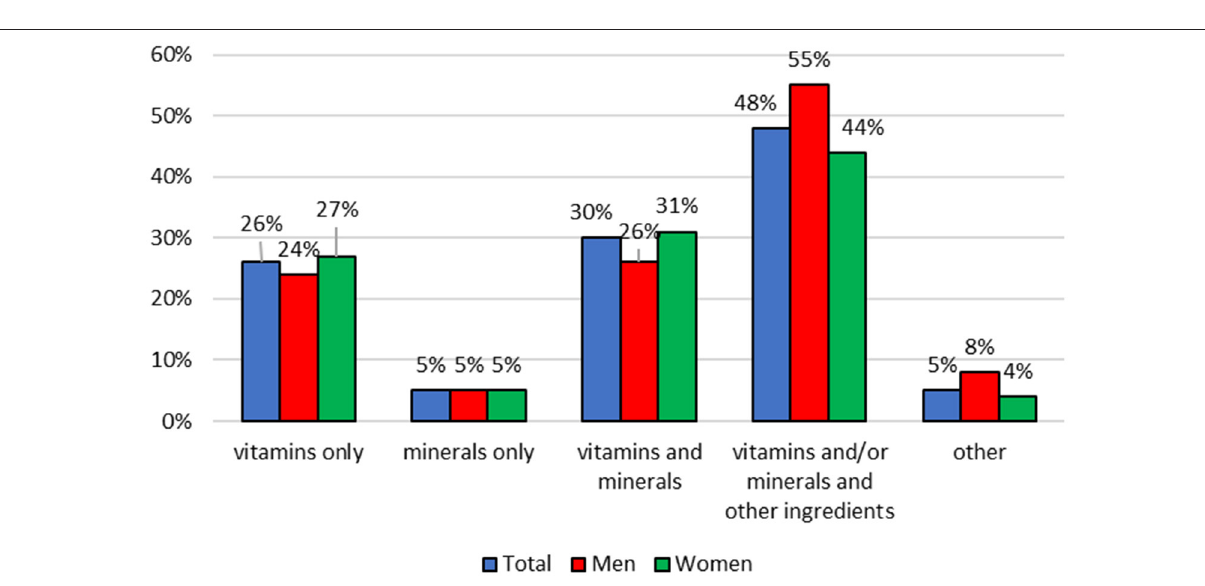
FIGURE 2 | Type of food supplements consumed in the day before the